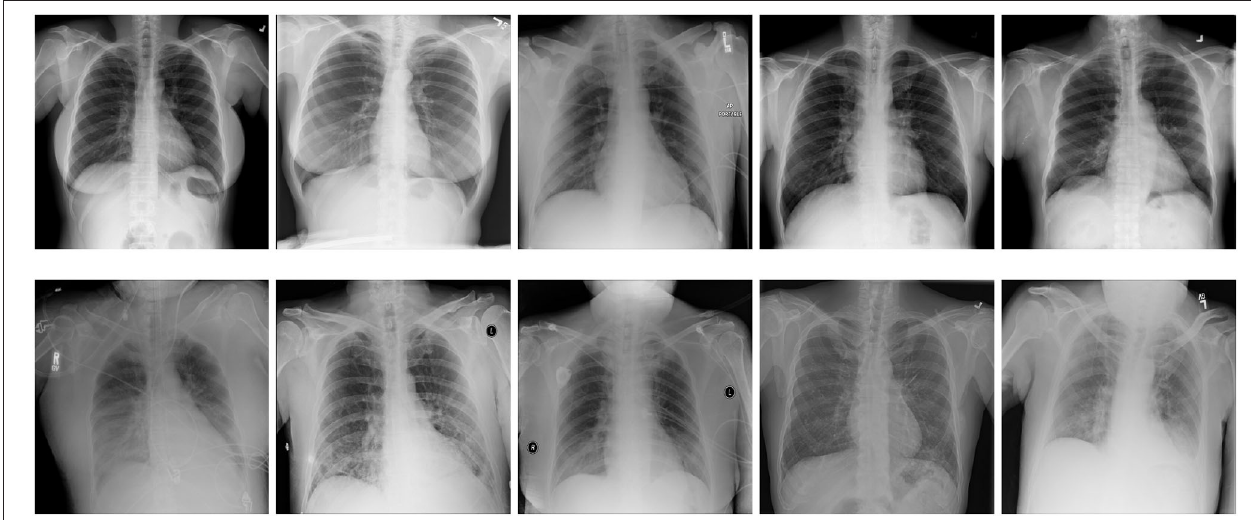
FIGURE 2 | Example images of the used dataset. The top row shows images that are labeled as Normal , while the bottom row shows images labeled as Lung Opacity , indicating lungs that are suffering from pneumonia.